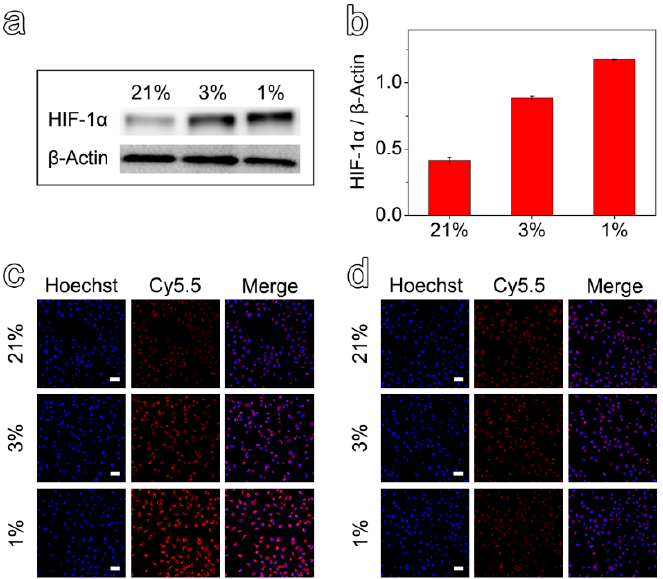
Figure 2. ( a ) Expression of HIF-1 α protein in MCF-7 cells incubated under the oxygen concentrations of 1%, 3%, and 21% for 12 h. ( b ) Semi-quantitative analysis of relative expression of HIF-1 α protein at different oxygen concentrations. Confocal fluorescence images of MCF-7 cells after incubation with Fe 3 O 4 -Met-Cy5.5 ( c ) or Fe 3 O 4 -Cys-Cy5.5 ( d ) at different oxygen concentrations (scale bar represents 50 μ m).